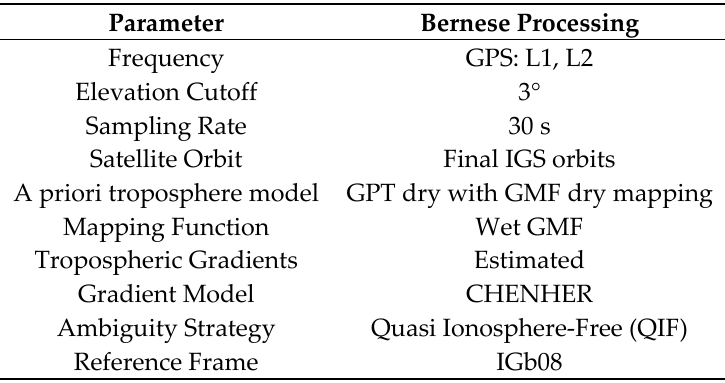
Table 1. Processing Parameters in Bernese GNSS Software.